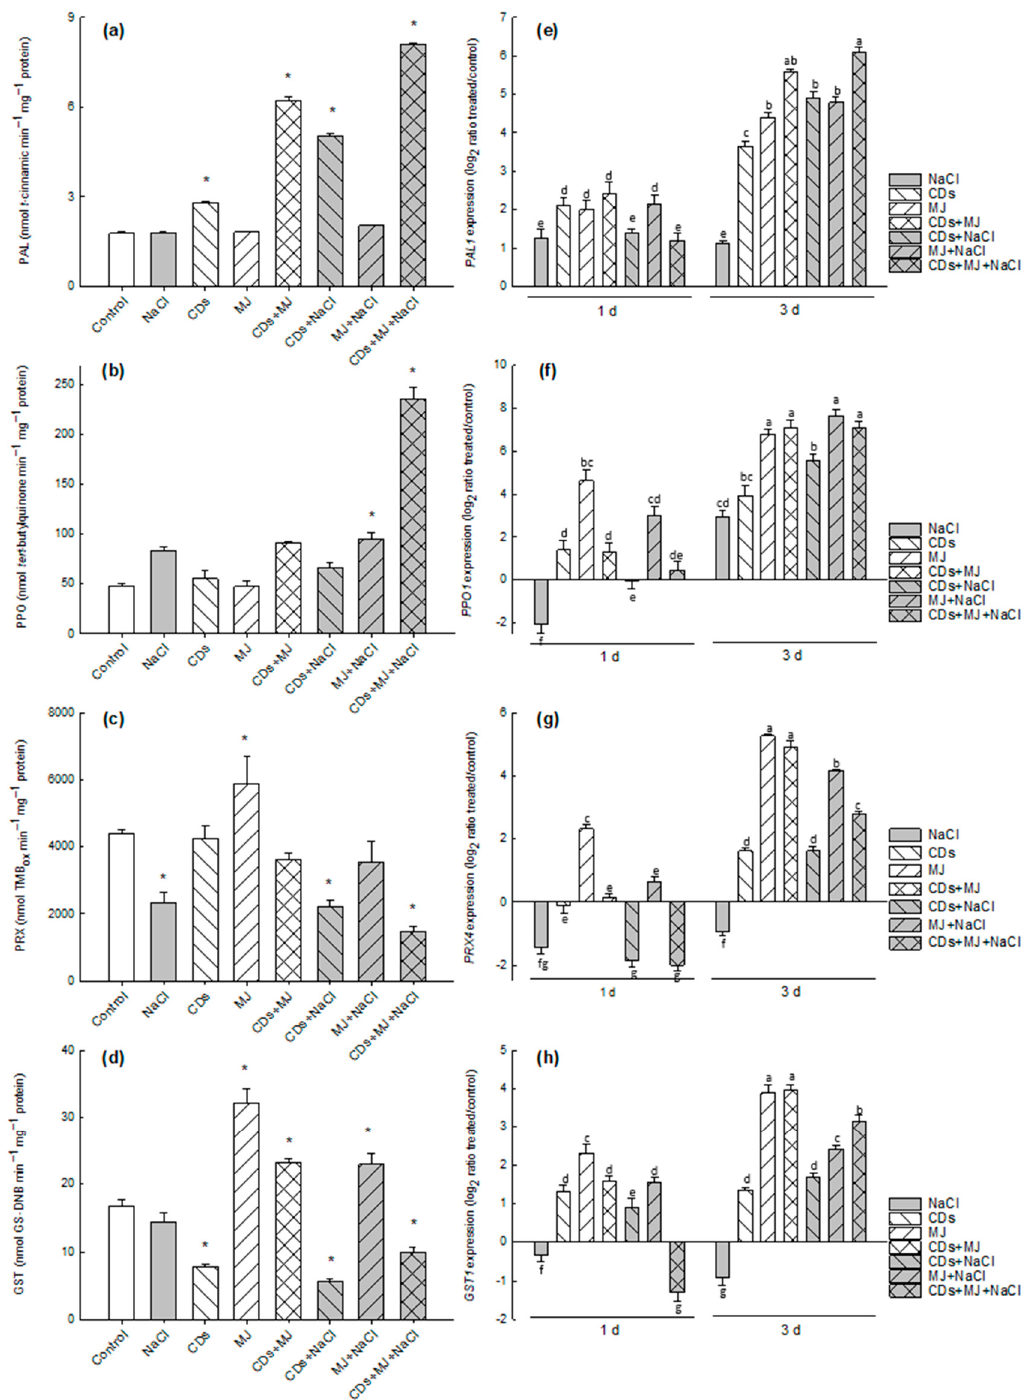
Figure 3. The effects of salt and/or elicitor treatments on the specific enzymatic activity of PAL ( a ), PPO ( b ), PRX ( c ), and GST ( d ), and the gene expression of PAL1 ( e ), PPO1 ( f ), PRX4 ( g ), and GST1 ( h ) analyzed by qRT-PCR. The data represent the mean ± SE of three independent replicates. Enzymatic values marked with an asterisk are significantly different from the control ( p < 0.05) by Tukey’s HSD test. The gene expression values followed by different letters are significantly different at p < 0.05 by Tukey’s HSD test.